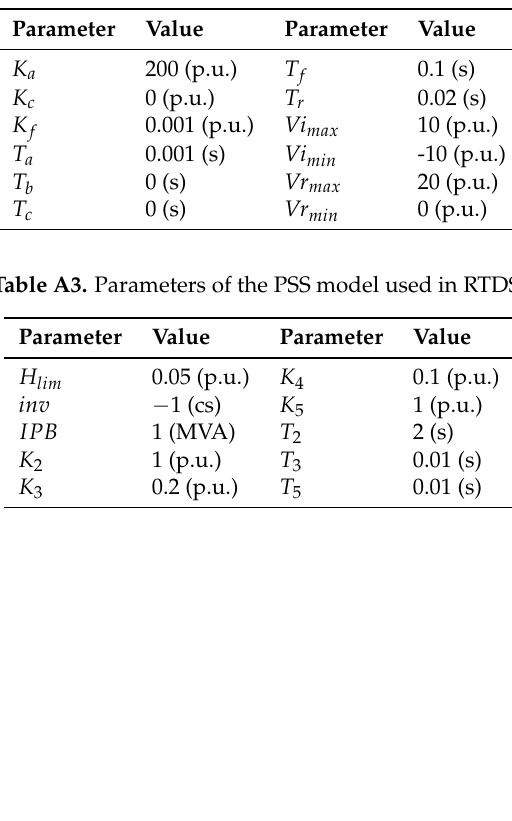
Table A2. Parameters of the Automatic Voltage Regulator (AVR) model used in RTDS.